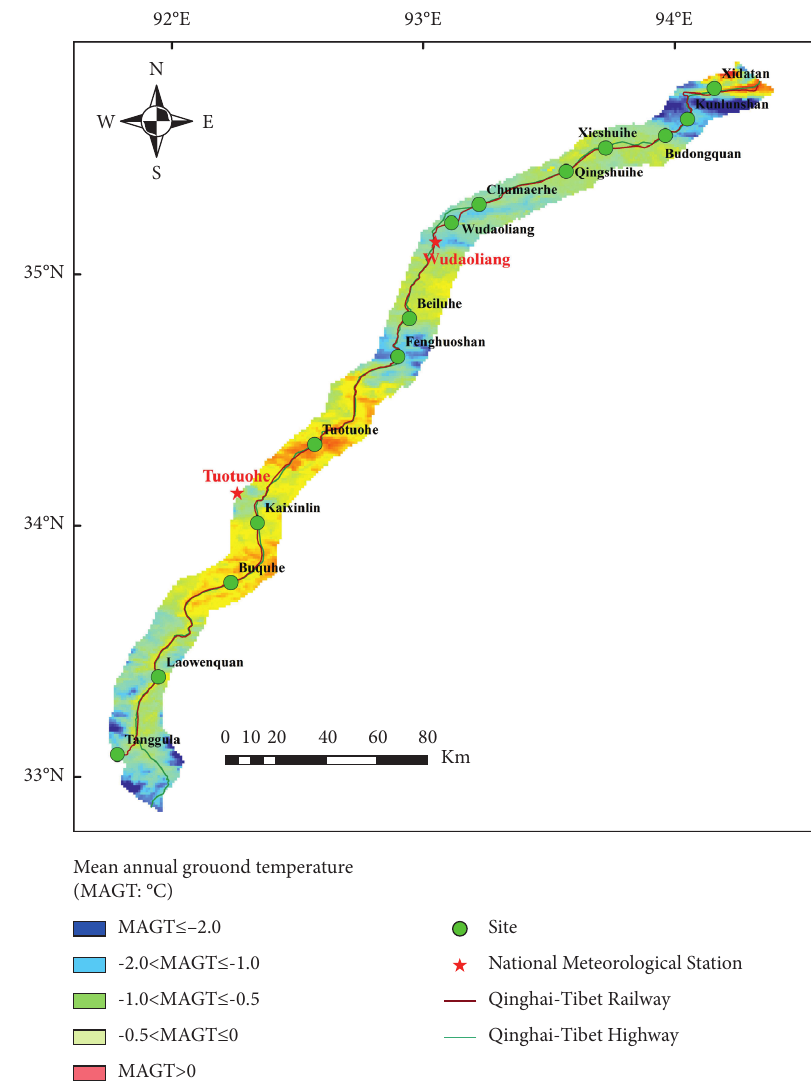
Figure 1: Mean annual ground temperature of permafrost along the QTEC. Note: the ground temperature distribution map was modified based on the data provided by Yin and Niu, and the original data can be used in public for scientific research and downloaded by registration (DOI: